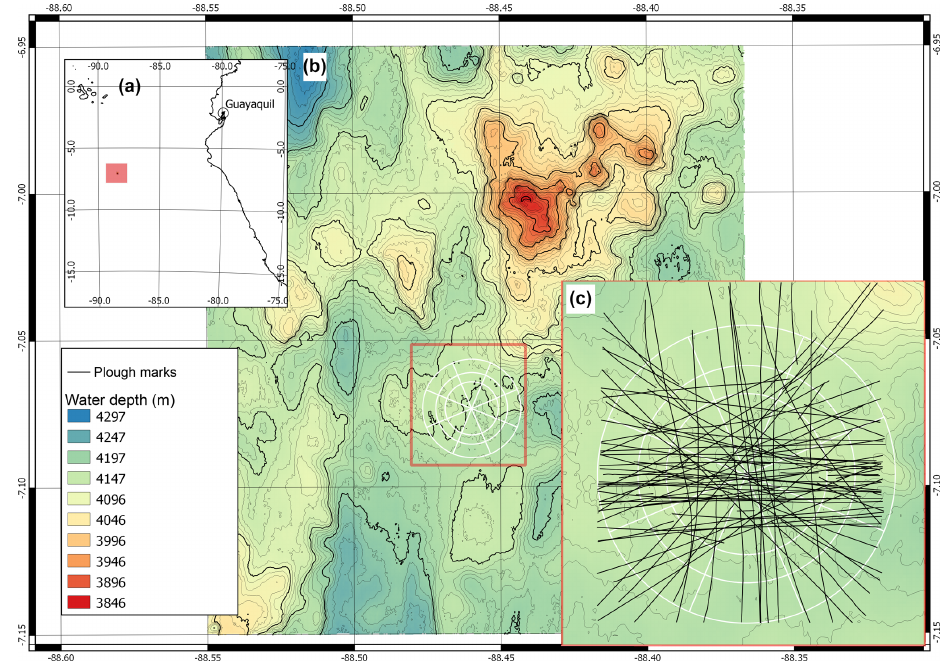
Figure 1. (a) Location of the DISCOL experimental area (DEA) in the Peru Basin (SE Pacific; red square), (b) detailed map of the DEA indicated by the white circle, (c) location of all plough tracks (black lines) that were observed by the “AUV Abyss” (Geomar Kiel) after 26 year during the R/V Sonne cruise SO242-1 (Greinert,